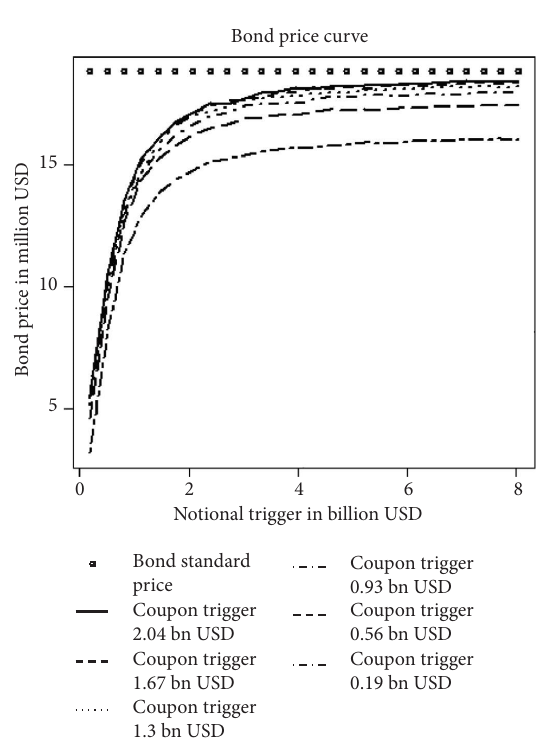
Figure 20: Cyber bond price